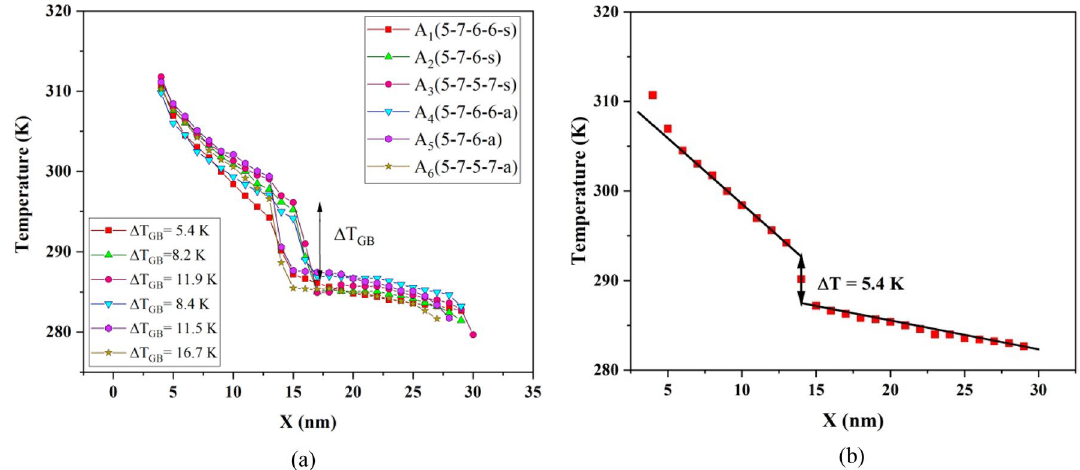
Figure 4. ( a )The steady-state one-dimension temperature profiles for BC 3 GrHs having grain boundaries- type A 1 , A 2 , A 3, A 4 , A 5 , A 6 along X direction with the same length of 30 nm at T = 300 K and ΔT = 40 K. ΔT GB is the temperature drop in the grain boundary, ( b ) the linear fitting performed on the temperature profile for